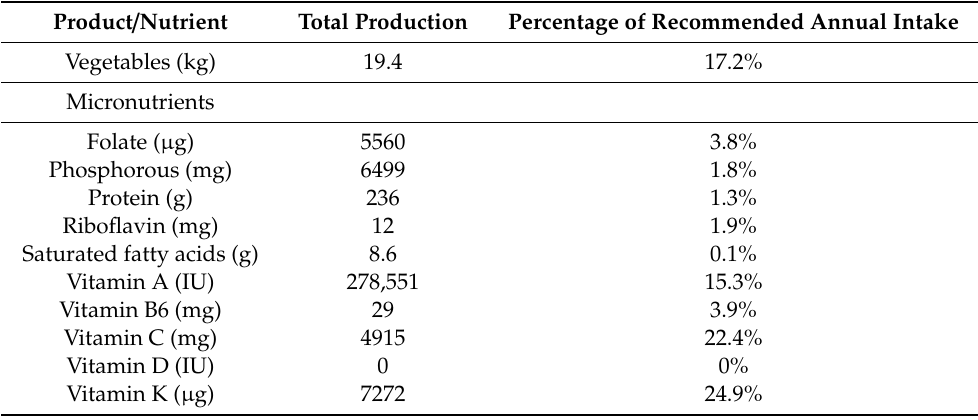
Table 1. Annual nutritional production from a 10 m 2 raised bed